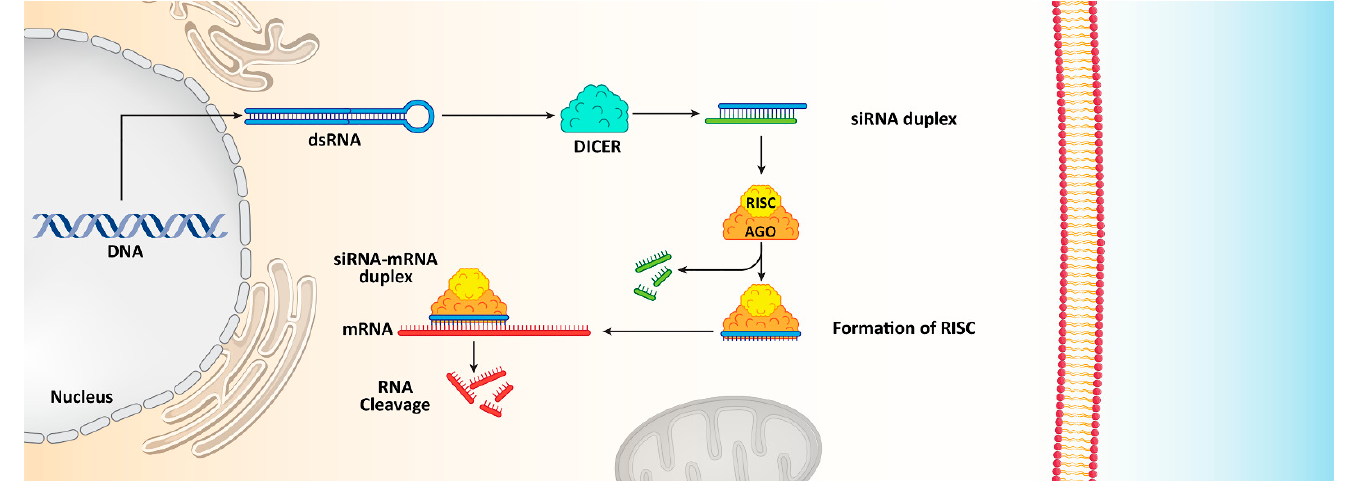
Figure 1. The functions of siRNA in reducing gene expression and causing mRNA cleavage.